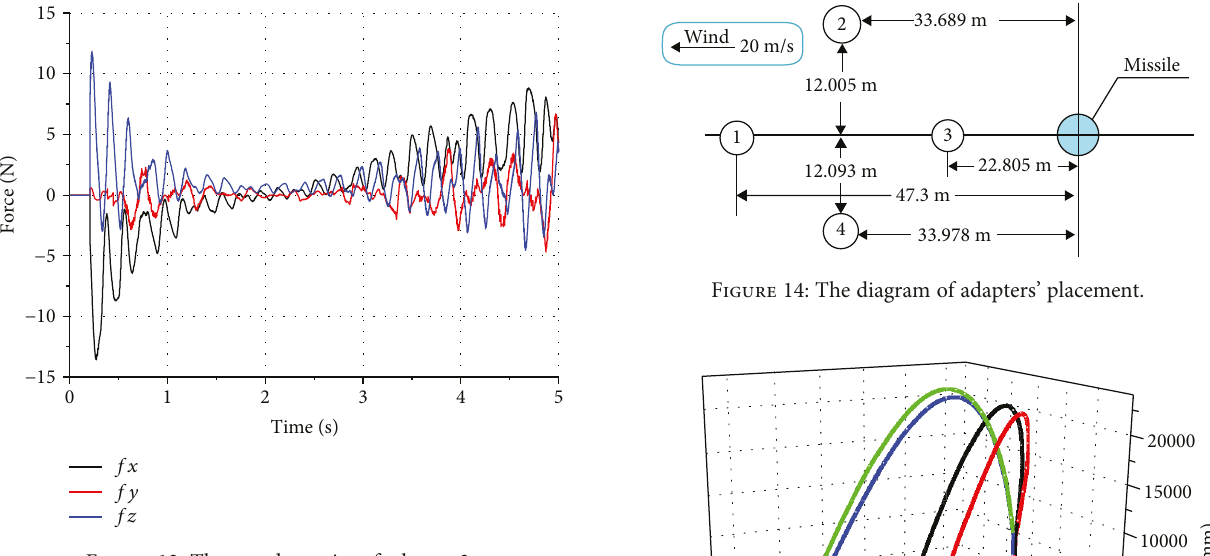
Figure 12: The aerodynamics of adapter 3.